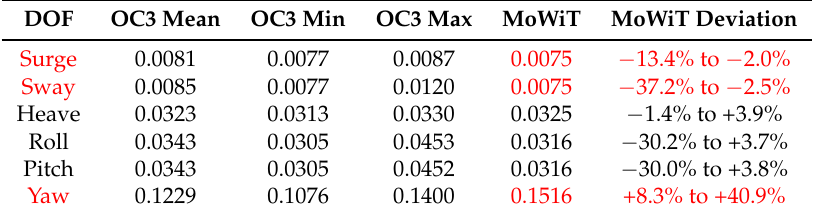
Table 9. Natural frequencies (in Hz) from OC3 and MoWiT in comparison, deviations are highlighted in red.